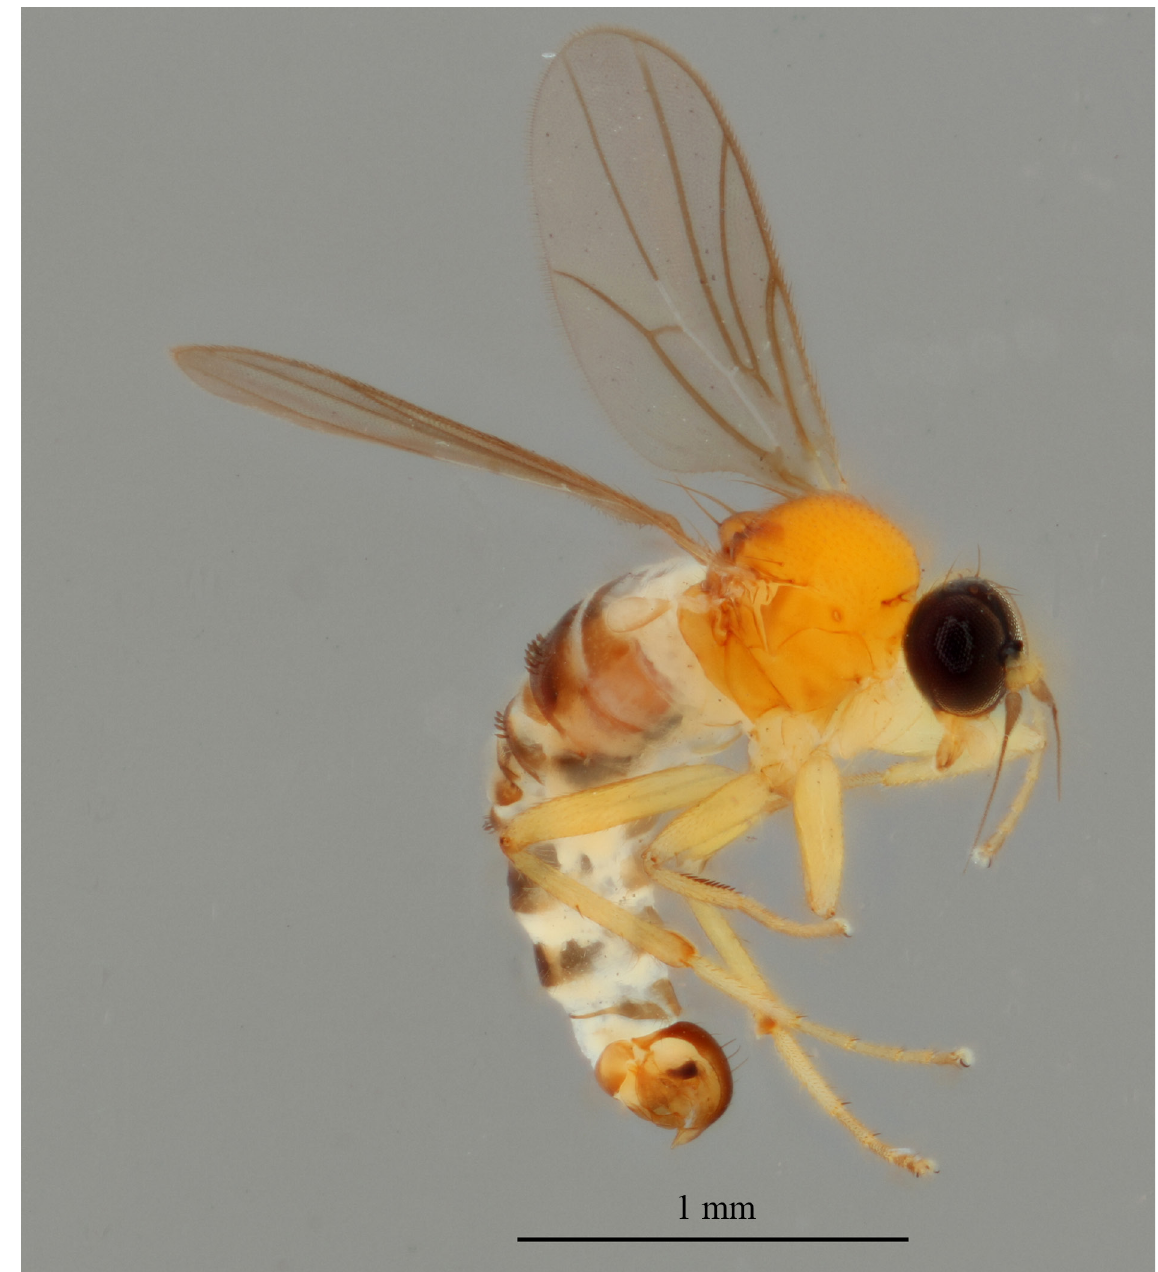
Fig. 5. Elaphropeza balinensis sp. nov. Male habitus (photo J.